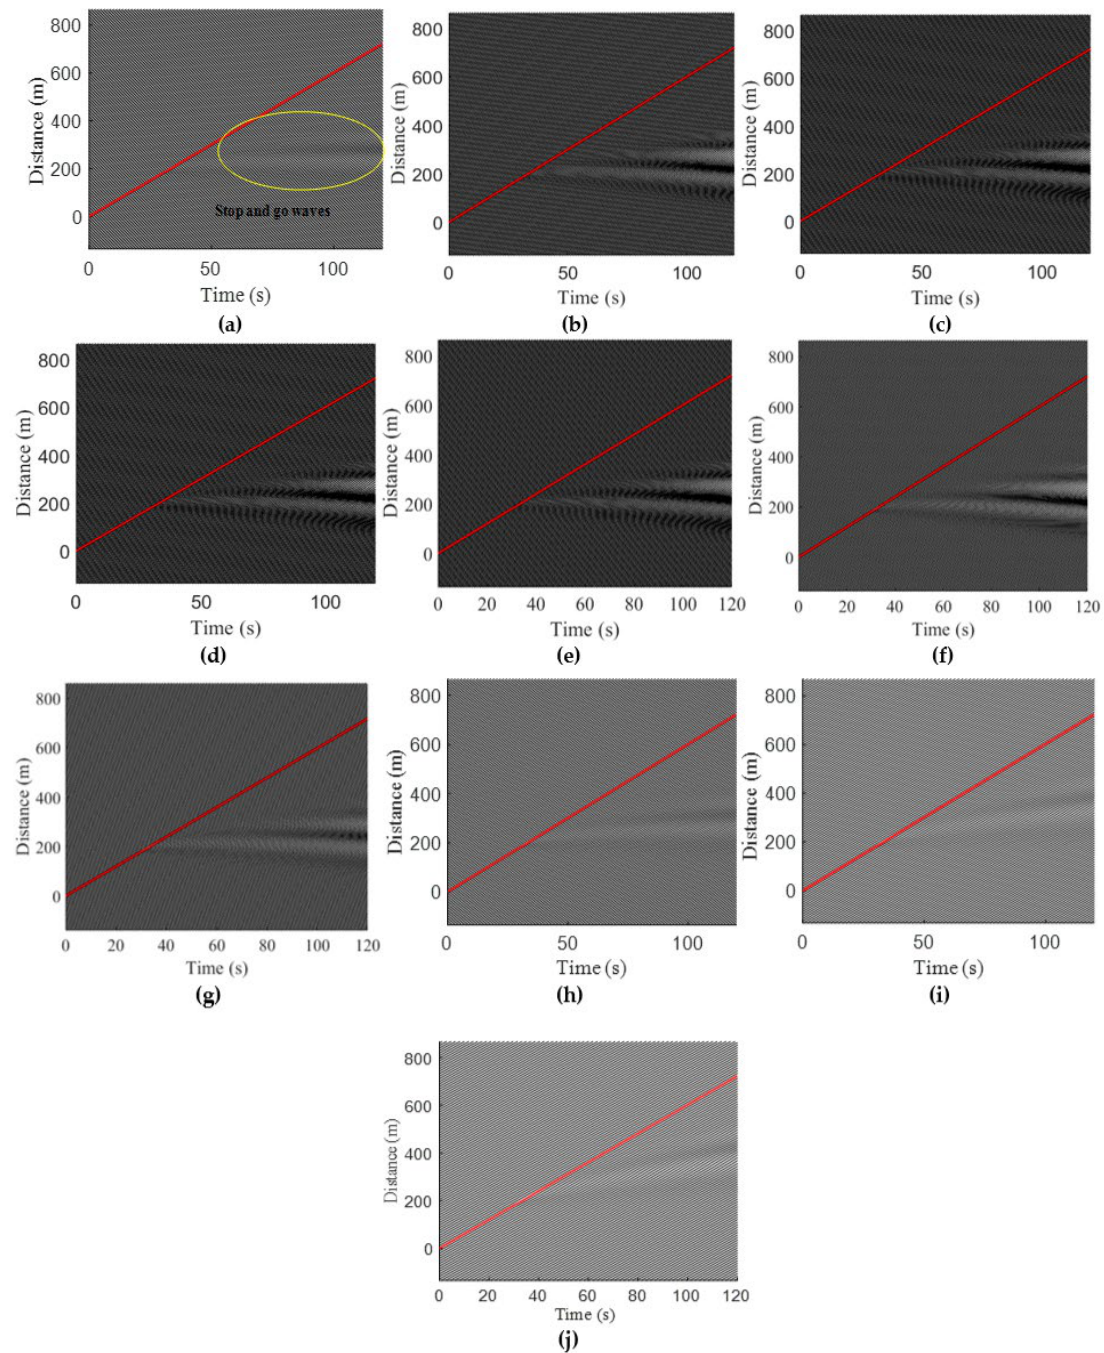
m circular road: Figure 4. Spatio-temporal performance of the ID and proposed models over a 1000 m circular 1000